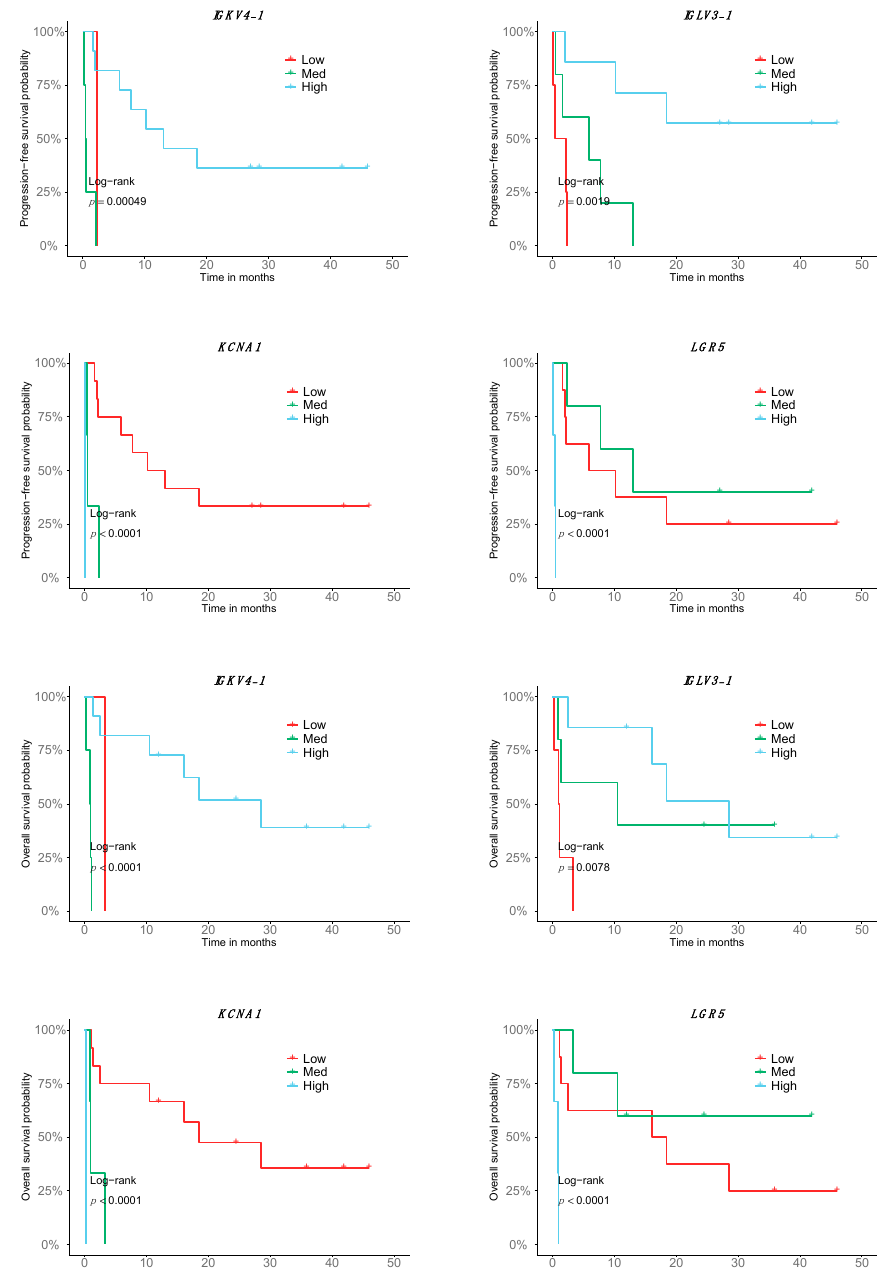
Figure 2. Association of the transcriptomic signature of response to Nivolumab with prognosis. Depiction of the top 8 genes with correlating expression with OS and PFS according to a stratification in low, high and medium expression (n = 16; 9 good responders, 7 bad responders).